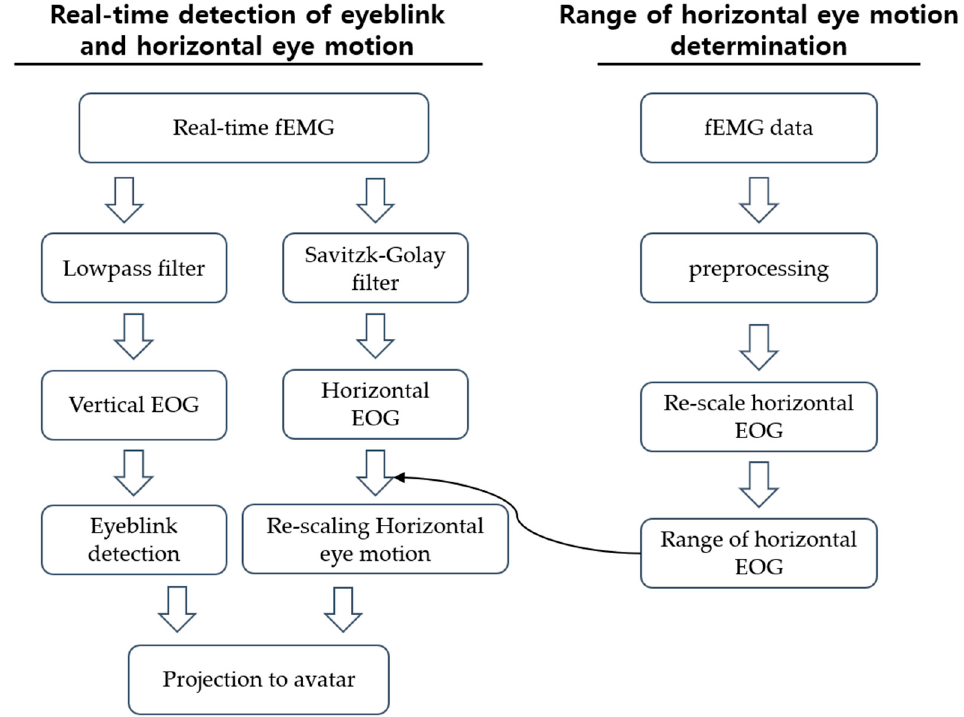
Figure 4. The right panel shows the overall procedure of eye blink and horizontal eye motion detection. The left panel presents the detailed method determining minimum and maximum ranges of horizontal EOG for re-scaling of the horizontal eye motion.